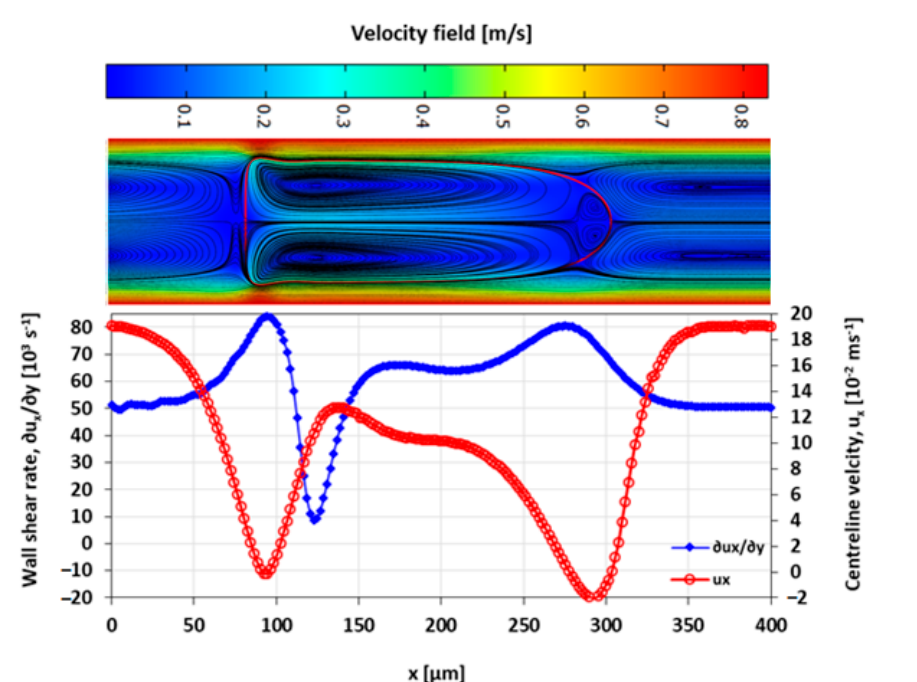
Figure 19. Wall shear rate and the x-velocity at centreline ( y = h /2) for λ = 0.5 and Ca = 0.2. The extent of the recirculation zone can be estimated from the intervals over which u x at the centreline drops below zero. At λ = 2, the recirculation zone at the leading edge of the droplet remains approximately constant with Ca , but at λ = 0.5 the cap length decreases with an increasing Ca , reducing the mixing